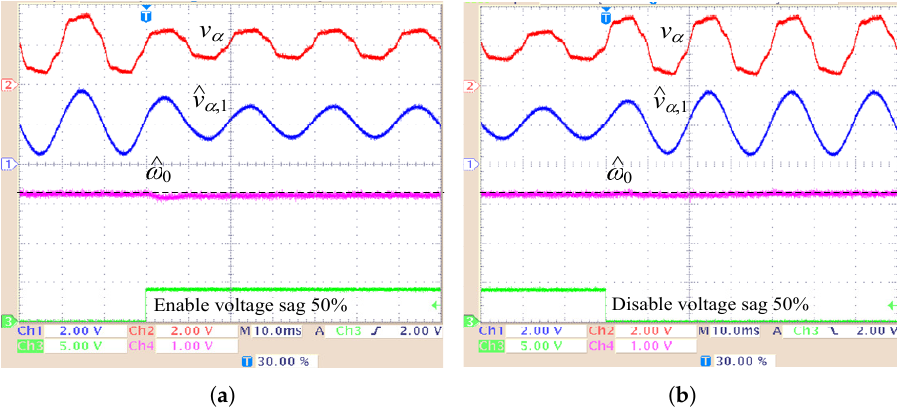
Figure 13. Transient responses of the proposed SOHO-based FLL after a voltage sag ( a ) from 100% to 50%, and ( b ) back from 50% to 100%, while keeping f 0 = 50 Hz and with harmonic distortion: (from top to bottom) v α , ˆ v α ,1 ( y -axis: 400 V/div), ˆ ω 0 ( x -axis: 10 ms/div; y -axis: 97.66 rad/s/div), and voltage-sag enable signal ( x -axis: 10 ms/div in all